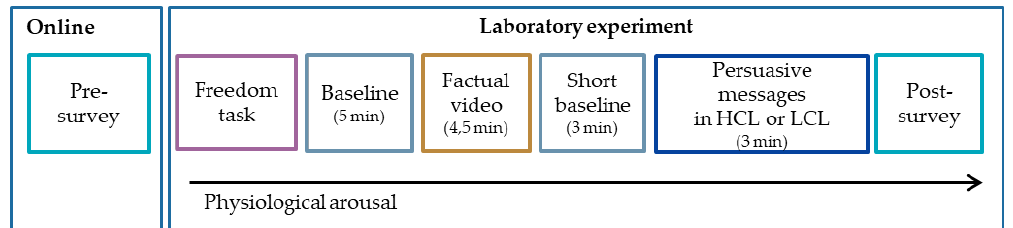
Figure 1. Experimental procedure during the laboratory experiment starting with a freedom exercise followed by a baseline measurement of physiology in rest, a factual movie about the consequences of meat consumption on health and environment, a second baseline, a persuasive message using high or low controlling language and a post-survey.